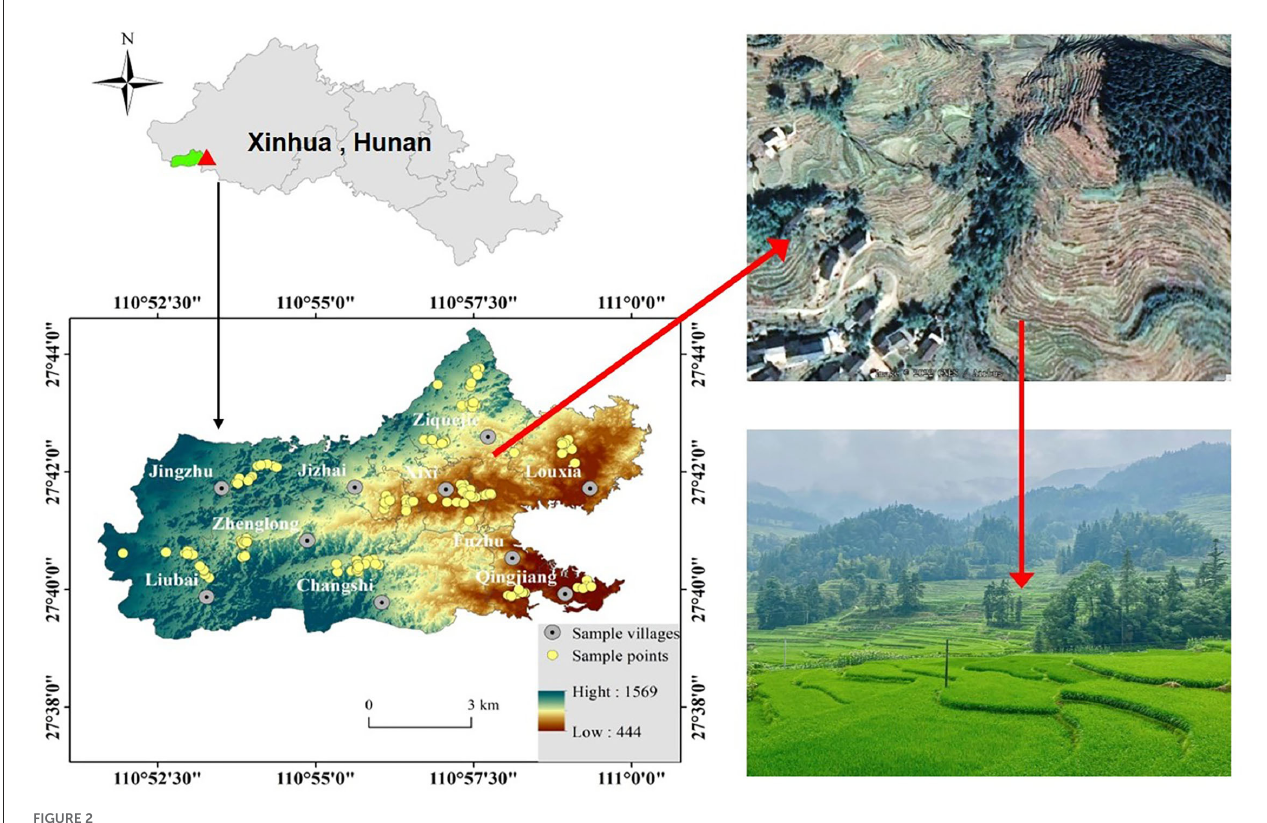
FIGURE2 Location of the study area and sample